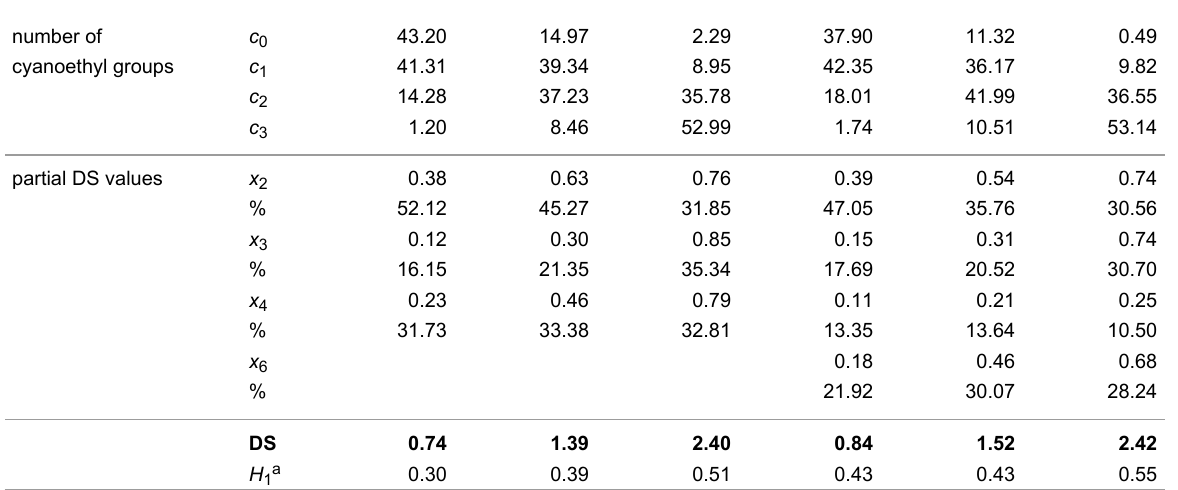
Table 2: Monomer composition [mol %] ( s n ) of un-, mono-, di- and tri-substituted glucose units ( c n ) (DS GC calculated without O -carboxyethyl dervia- tives) and partial degrees of substitution ( x n ) at position 2, 3, 4, 6; H 1 : heterogeneity parameter. (continued)